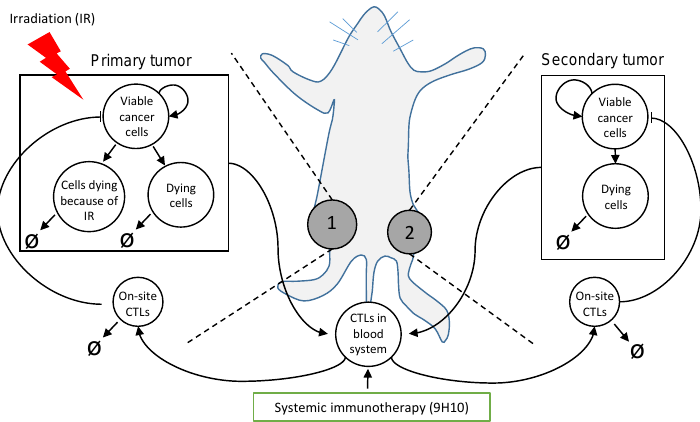
Figure 1. Schematic of the experimental setting and model compartments (circles). Arrows indicate transitions between compartments and T bars indicate killing of cancer cells by immune cells. The proposed model (Equations (3)–(10)) formalizes the relevant mechanisms underlying the in vivo experiment [11] in which carcinoma cells were injected subcutaneously into mice at two spatially-separated sites (left and right flank), and only one site (1, primary tumor) was later irradiated (IR). Some mice received also systemic immunotherapy (9H10), which augments activation of tumor-specific cytotoxic T lymphocytes